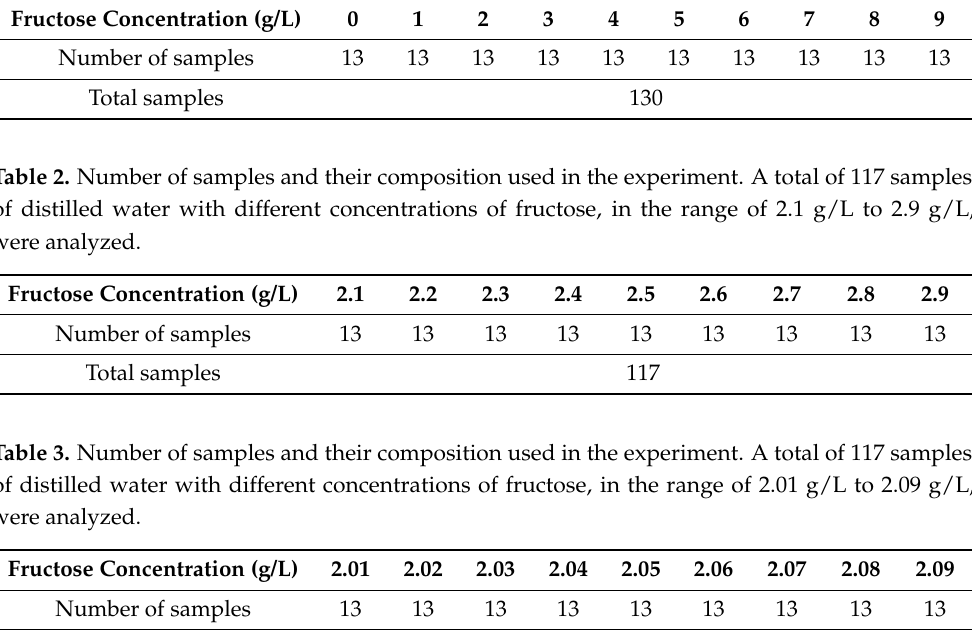
Table 1. Number of samples and their composition used in the experiment. A total of 130 samples of distilled water with different concentrations of fructose, in the range of 0 g/L to 9 g/L, were analyzed. Fructose Concentration (g/L)